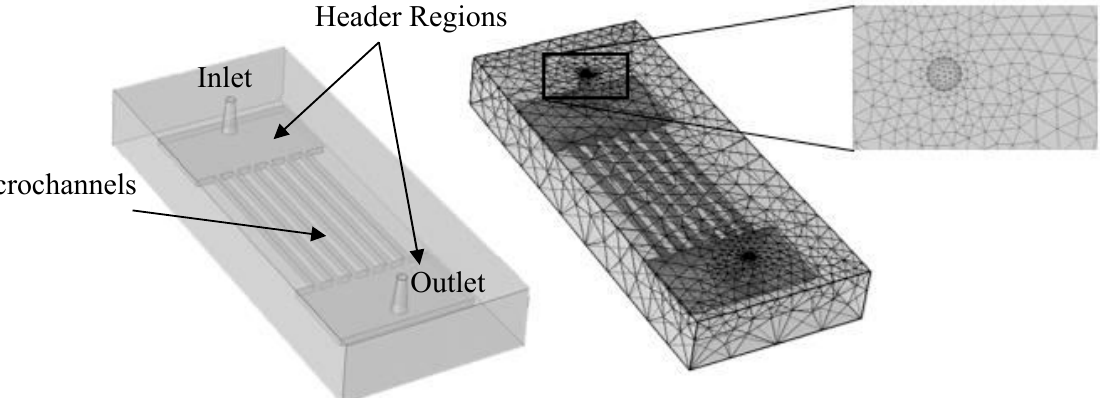
Figure 4. Example of the geometry used in the heat transfer simulation, wherein both domains of the simulation can be seen. The mesh comprises different regions, namely, the zone where the fluid flows, the solid region around that zone, and a localized transition in the boundary between both.